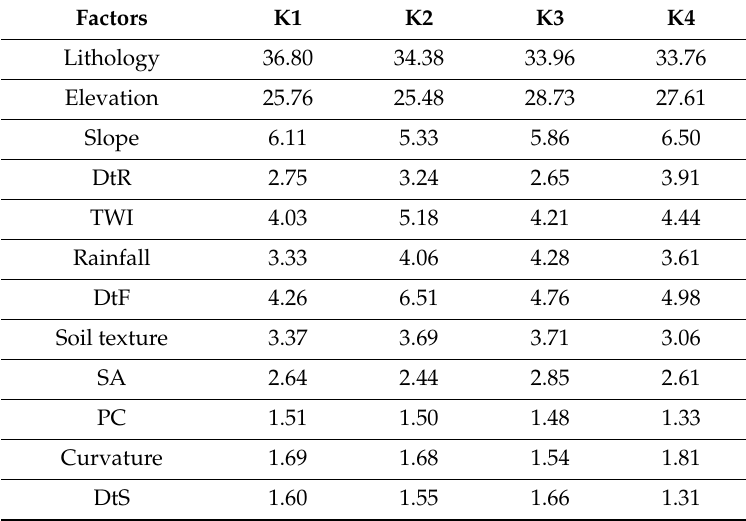
Table 3. Several variables importance in landslide occurrences using random forest (RF) algorithm in four k-fold systems of the present study area.